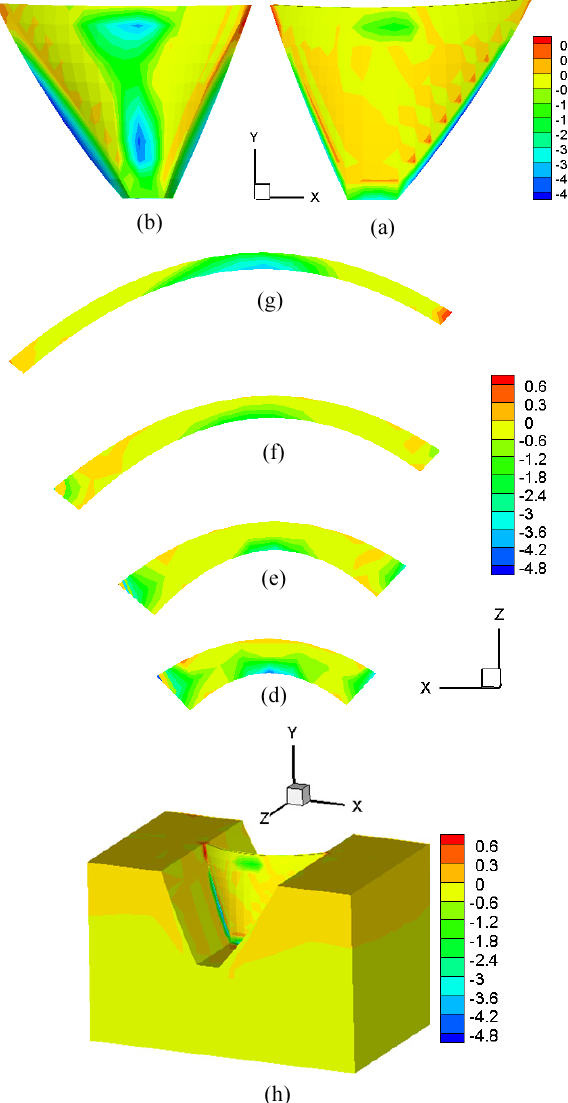
Fig. 8. Principal stress distribution (σ 2 ) at the end of dam const- ruction